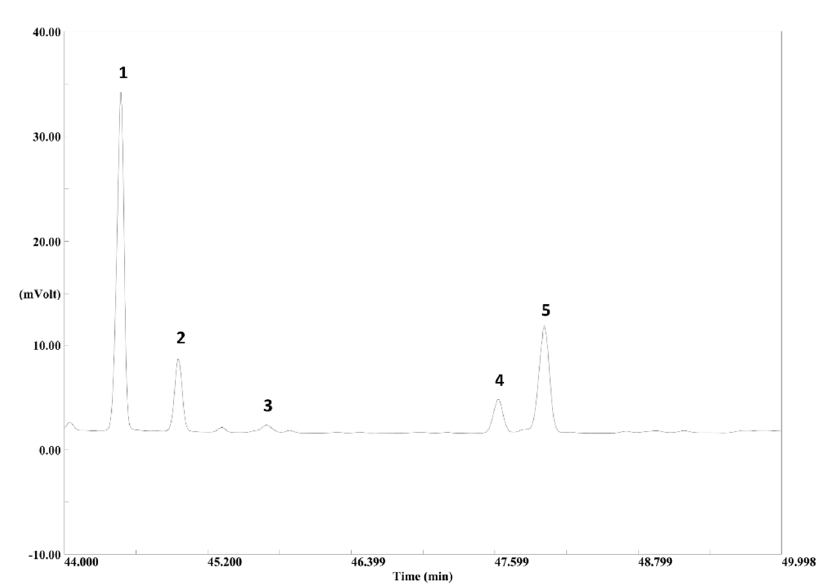
Figure 3. The typical diterpenoid profile of 23 (Russia) obtained by GC-FID: ( 1 ) isoabienol, ( 2 ) sandaracopimaral, ( 3 ) cis -abienol, ( 4 ) palustral and ( 5 ) isopimaral.